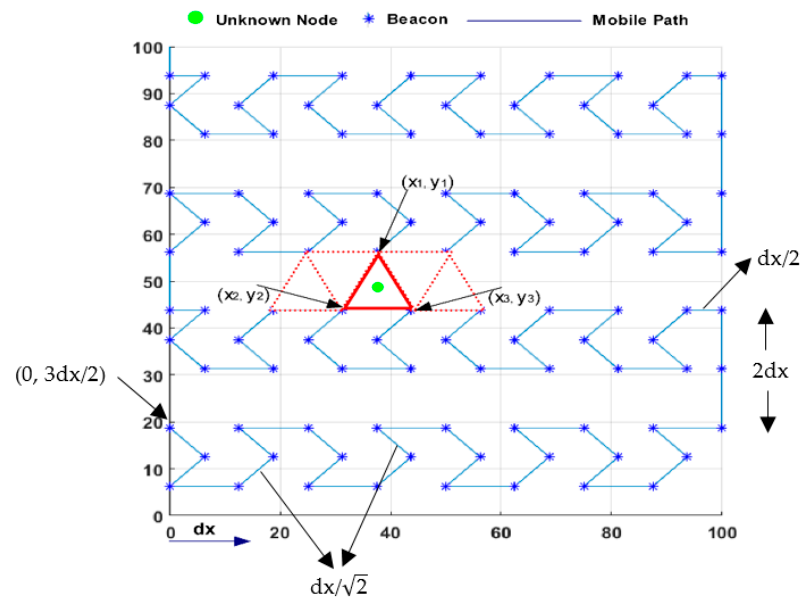
Figure 8. The proposed anchor path trajectory—NHexCurves.